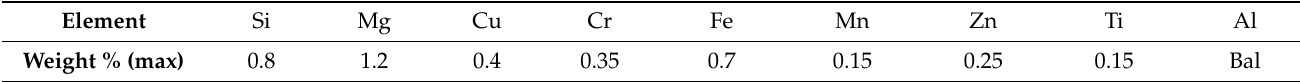
Table 1. Chemical standard composition of Al 6061-T6 alloy plate